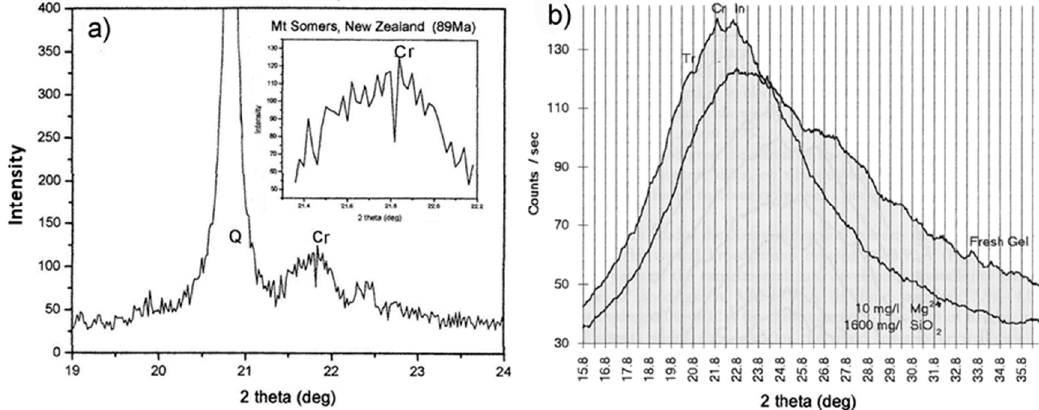
Figure 6. ( a ) An expanded examination of the cristobalite (Cr) and a possible tridymite signal. ( b ) XRD diffractogram of a 14-year-old silica gel and a fresh gel control. The aged gel shows small development peaks that were attributed to tridymite and cristobalite and an unidentified intermediate signal (In) (after Moxon